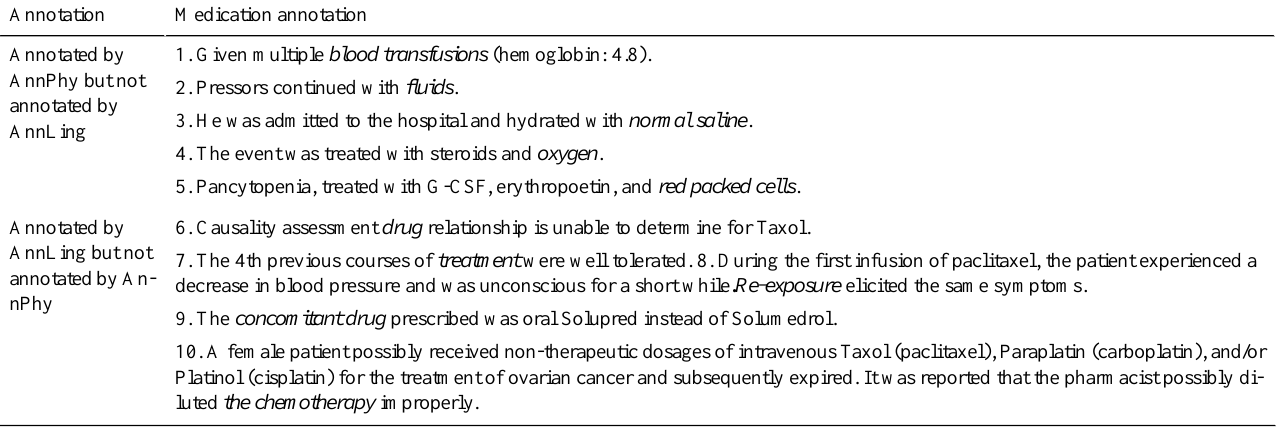
Table 4. Disagreement in medication annotation (medication text is